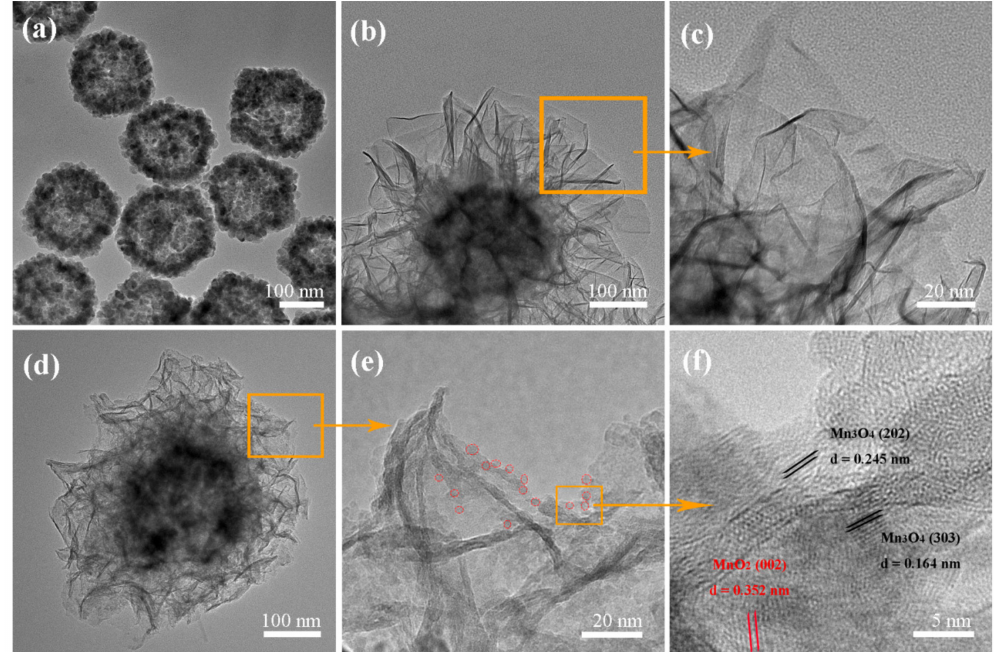
Figure 2. TEM images of hollow Fe 3 O 4 microspheres ( a ), hollow flower-like Fe 3 O 4 / MnO 2 microspheres ( b , c ), and hollow flower-like Fe 3 O 4 / MnO 2 / Mn 3 O 4 photocatalyst ( d – f ).